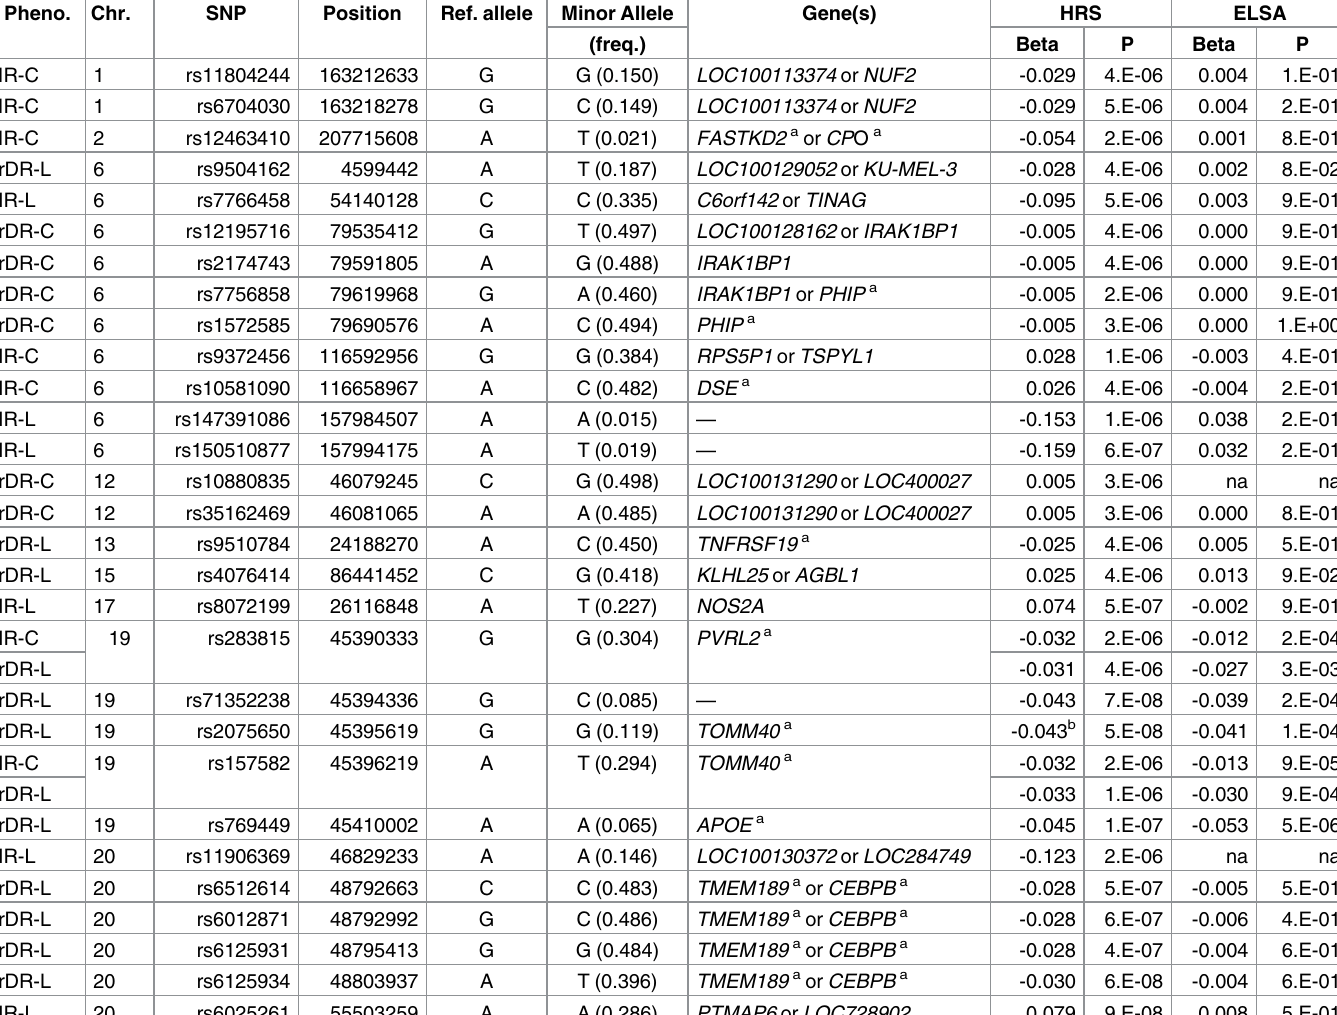
Table 3. Strongest associatedSNPs detected by GWASs in the HRS discoverysample and comparisons in the ELSA replication sample, for imme- diate recall level (IR-L) and change (IR-C) and residual delayed recall level (rDR-L) and change (rDR-C). Pheno.